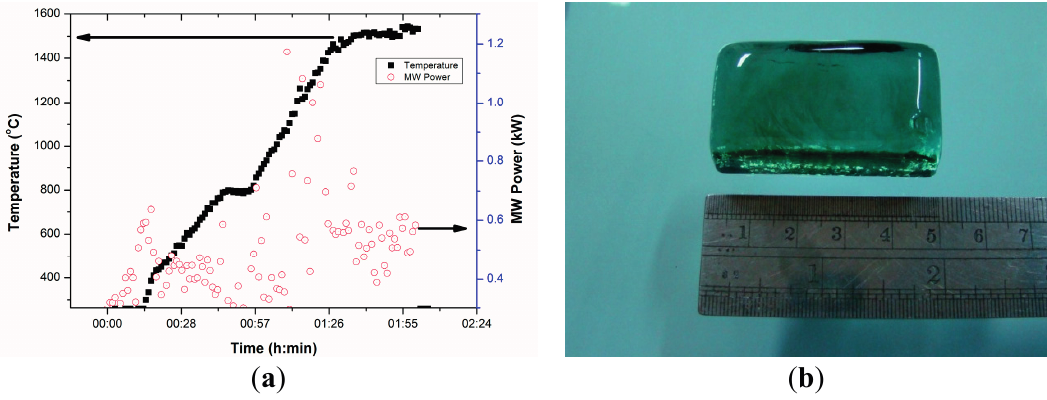
Figure 14. ( a ) T-P-t profile for FAP glass under direct microwave heating of peletized glass batch. ( b ) Photograph of annealed glass melted by microwave